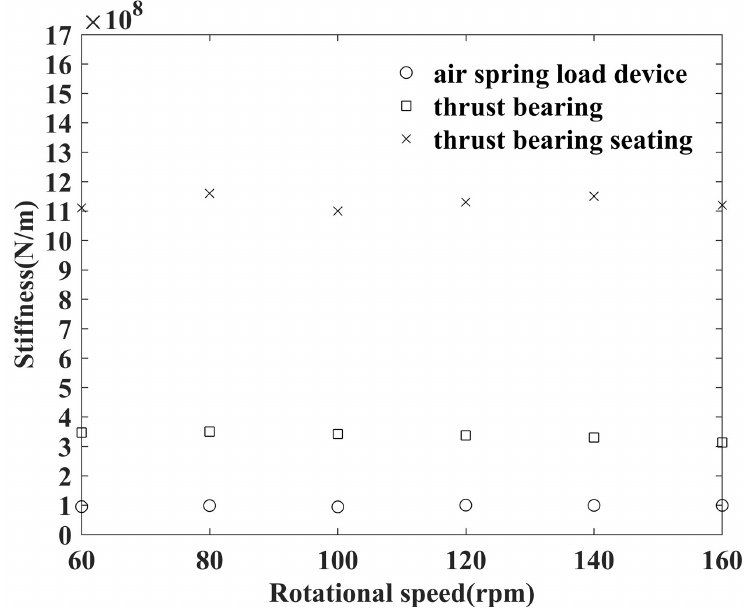
Figure 6. Results of